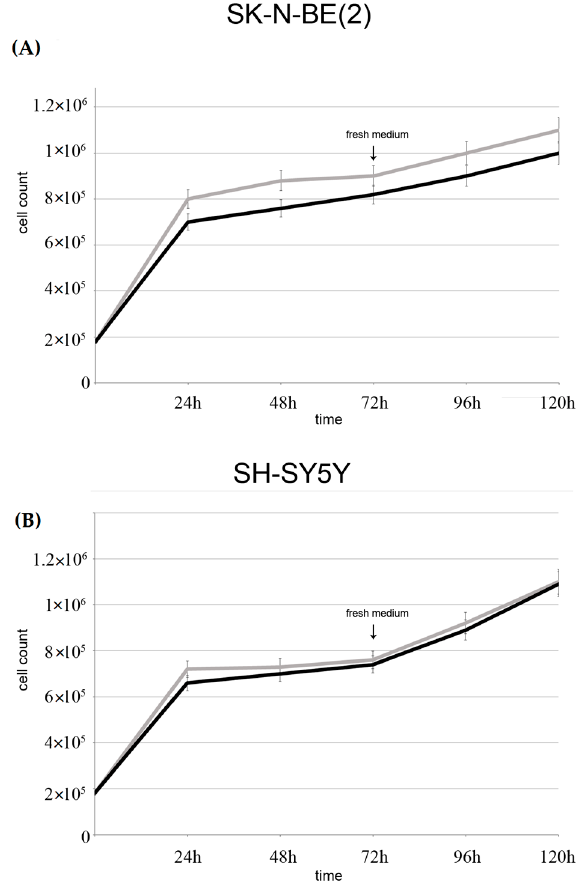
Figure 8. Growth curves of SK-N-BE(2) and SH-SY5Y cells: SK-N-BE(2) ( A ) cells; and SH-SY5Y cells ( B ) were treated with GO (2.0 μ g/mL) for up to 72 h. Medium was changed at 72 h and cultures were allowed to grow for 96 and 120 h. At the end of incubation time, cells were stained with Trypan blue dye and counted on a hemocytometer. Data are mean of three independent experiments ± SD.